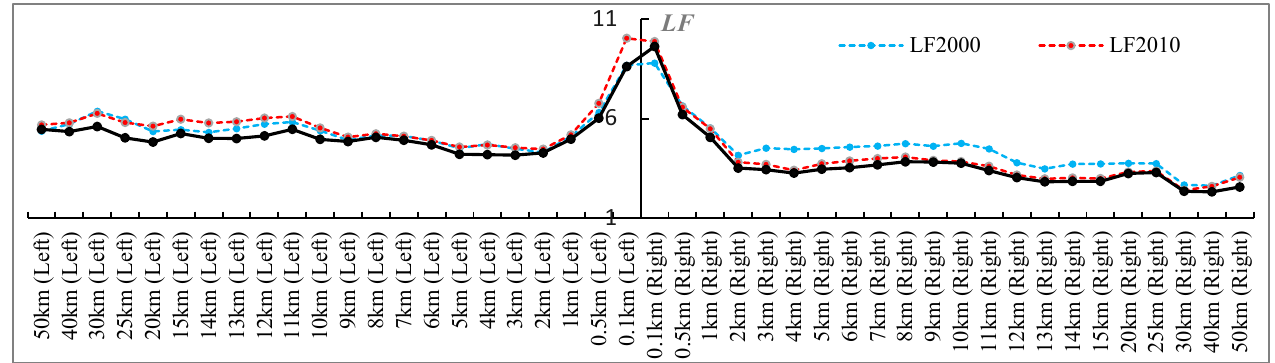
Figure 3. LF of different buffers on the left and right sides along the QTR.